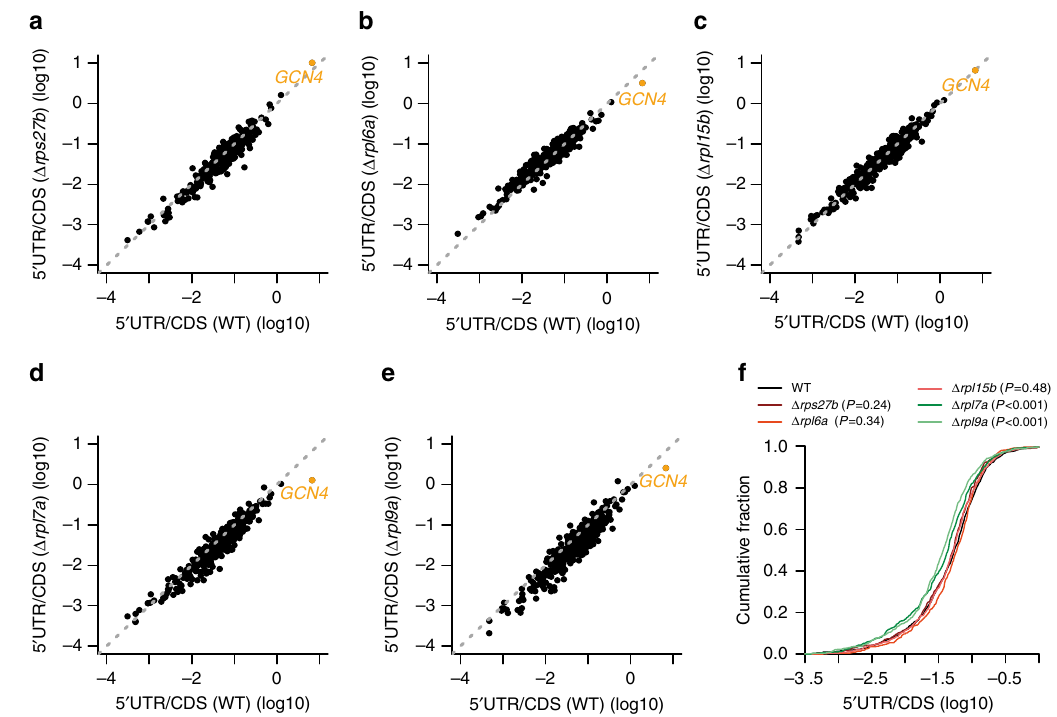
Fig. 3 Generalized uORFs skipping in long-lived RPKO strains. a – e 5 ′ UTR-to-CDS Ribo-seq reads ratio for a Δ rps27b , b Δ rpl6a , c Δ rpl15b , d Δ rpl7a , and e Δ rpl9a strains compared to the wild-type strain. Each dot corresponds to a gene containing at least one uORF. The GCN4 gene is highlighted in orange . f Cumulative distribution functions for the different strains studied indicate that only long-lived strains show a signi fi cant decrease in the 5 ′ UTR-to-CDS ratio compared to the wild-type strain. The comparison of the distributions of ratios between the different RPKO and the wild type was performed with the Mann – Whitney U test and the P -values for the two-tailed test are indicated. See Supplementary Fig. 3 for the similar analysis of uORF-to-CDS